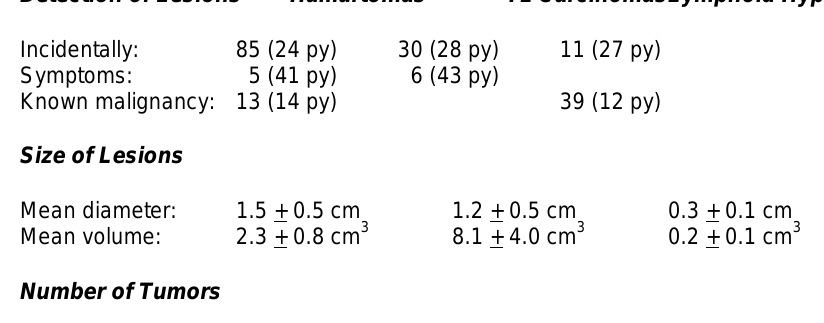
Detection of Lesions, Histopathologic Compartments, and Tumor Size of Hamartomas